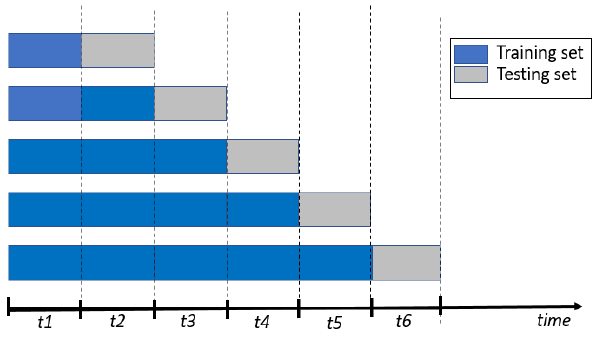
Figure 1. The walk-forward technique for 6